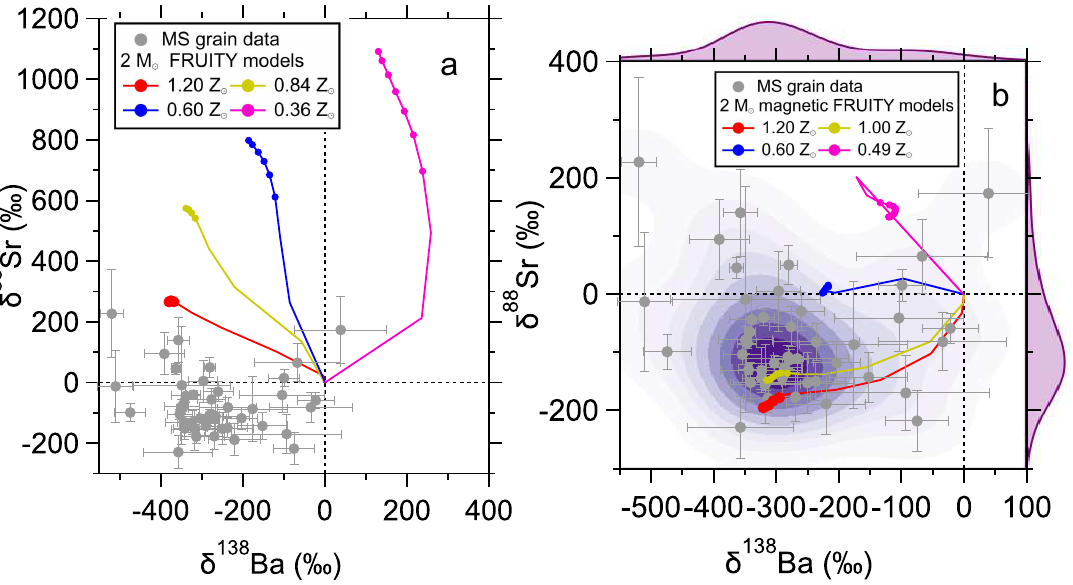
Figure 5. Strontium and Ba isotope plots comparing MS grain data from [62,79] with FRUITY model calculations that consider no magnetic effects [9,75] in panel ( a ) and magnetic effects in panel ( b ) (the same as the default magnetic FRUITY models in Figure 4). The normalization isotopes for δ 88 Sr and δ 138 Ba are 86 Sr and 136 Ba, respectively. Error bars are all 1 σ. Note that the metallicities of the two sets of models are slightly different.